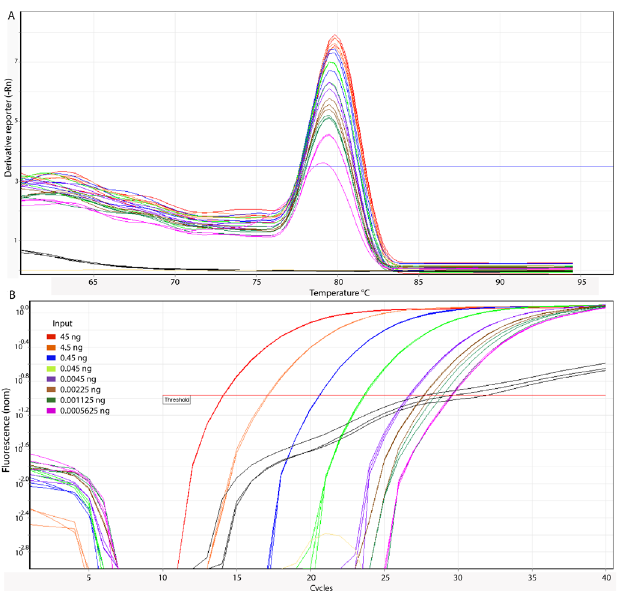
Figure 2. (A) Quantitation curves of known amounts and (B) melting curves of known amounts to 45 (red), 4.5 (orange), 0.45 (blue), 0.045 (light green) 0.0045 (purple), 0.00225 (brown), 0.001125 (dark green), 0.0005625 (pink) ng of DNA/reaction of L. fortunei DNA. Negative controls are shown in black